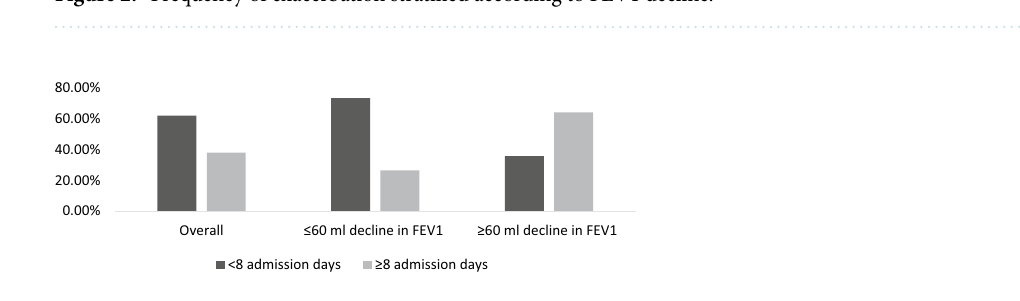
Figure 3. Hospital admission days stratified according to FEV1